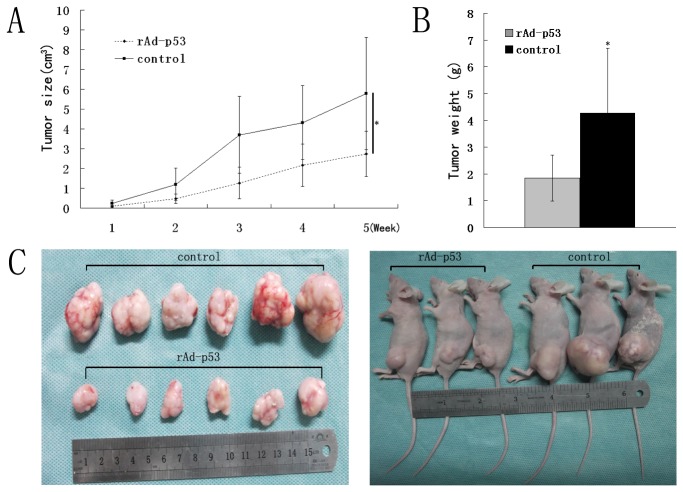
rAd-p53 inhibits tumor growth in vivo.Multicenter intratumoral administration of rAd-P53 in Hep3B subcutaneous tumor in nude mice was monitored over time. Tumor size and weight was plotted in A), and B) respectively. C) Exemplarily, tumor bearing mice and explanted tumors are depicted. Values are mean±standard error. * P<0.05 vs rAd-p53.